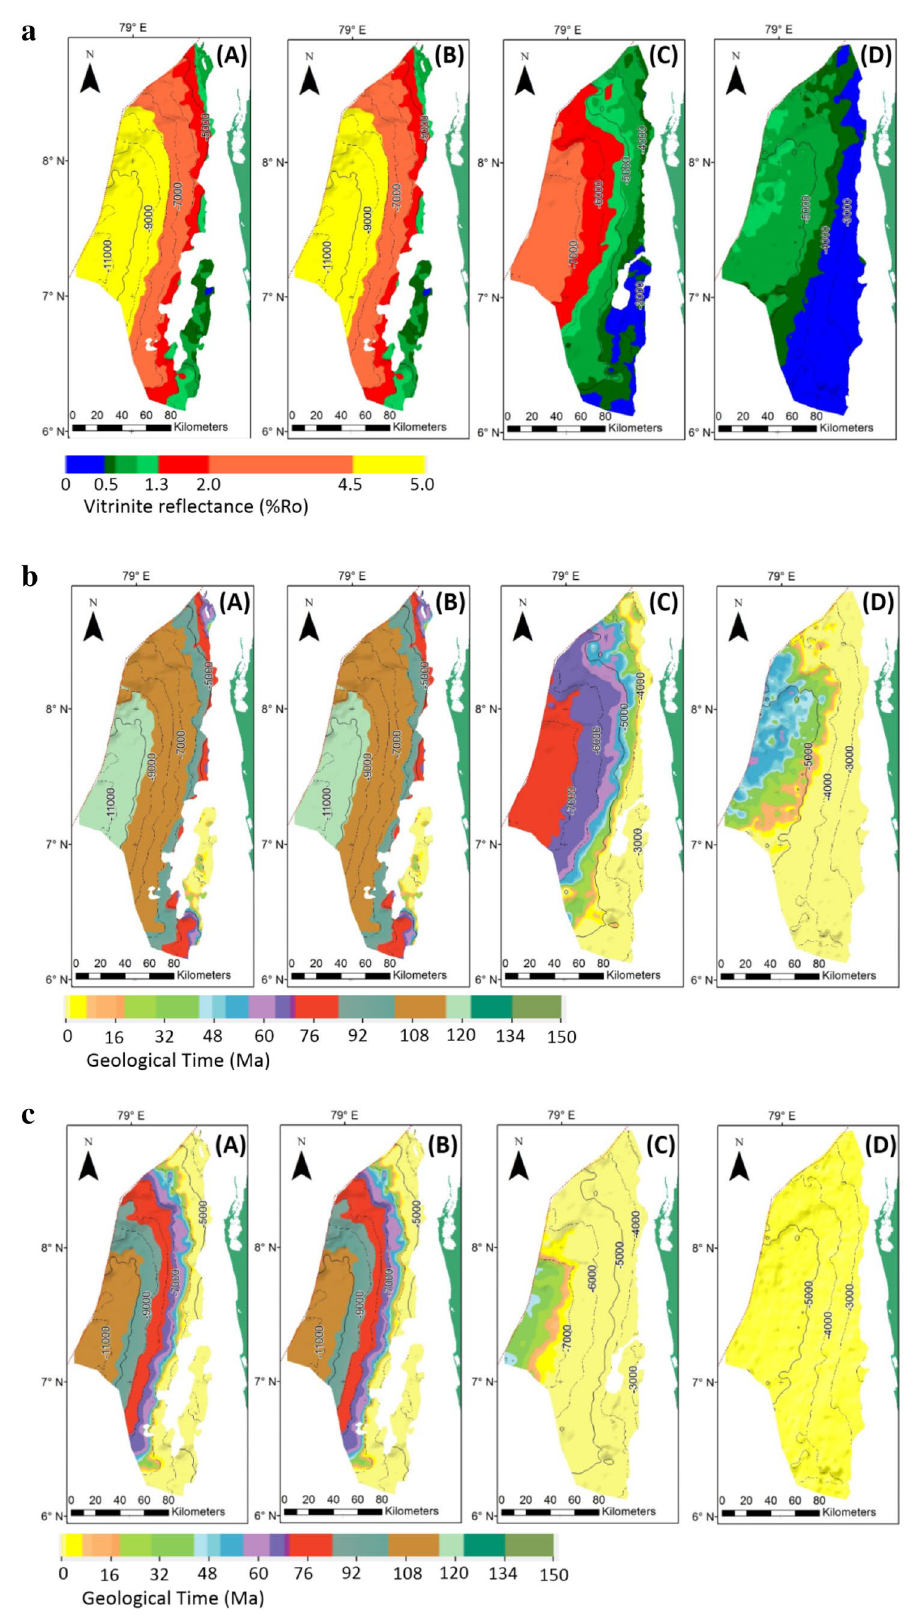
Fig. 9 a Maturity maps of potential source rocks. Where, yellow colour (%Ro 5.0–4.5) indicates the over mature win- dow, brownish orange colour (%Ro 4.5–2.0) indicates the dry gas window, red colour (%Ro 1.0–1.3) indicates the wet gas window, light to dark green colour (%Ro 1.3–0.5) indicates the oil window and blue colour (%Ro 0.5–0) indicates the immature window, b geologi- cal time at which each potential source rock levels enters the main oil window and c geologi- cal time at which each potential source rock levels enters the gas window. Where, (A) Late Juras- sic Type I source rocks, (B) Late Jurassic Type III source rocks, (C) Albian Type II source rocks (D) Campanian–Maas- trichtian Type II source